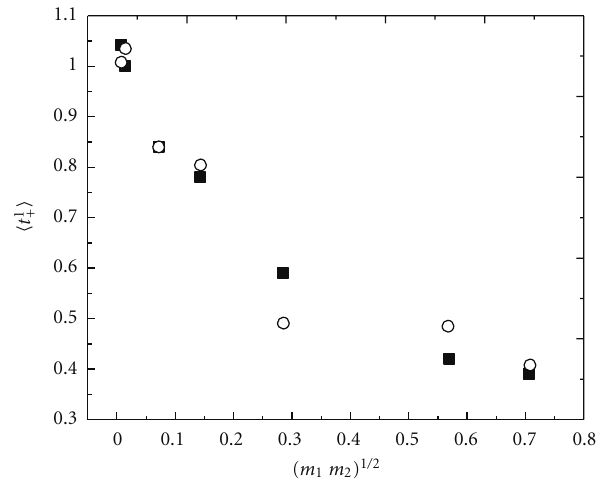
Figure 6: Variation of the apparent proton transport number with the geometric average of the molality of the solutions flanking the membrane in P5FNDIHS (squares) and C5FNDIHS